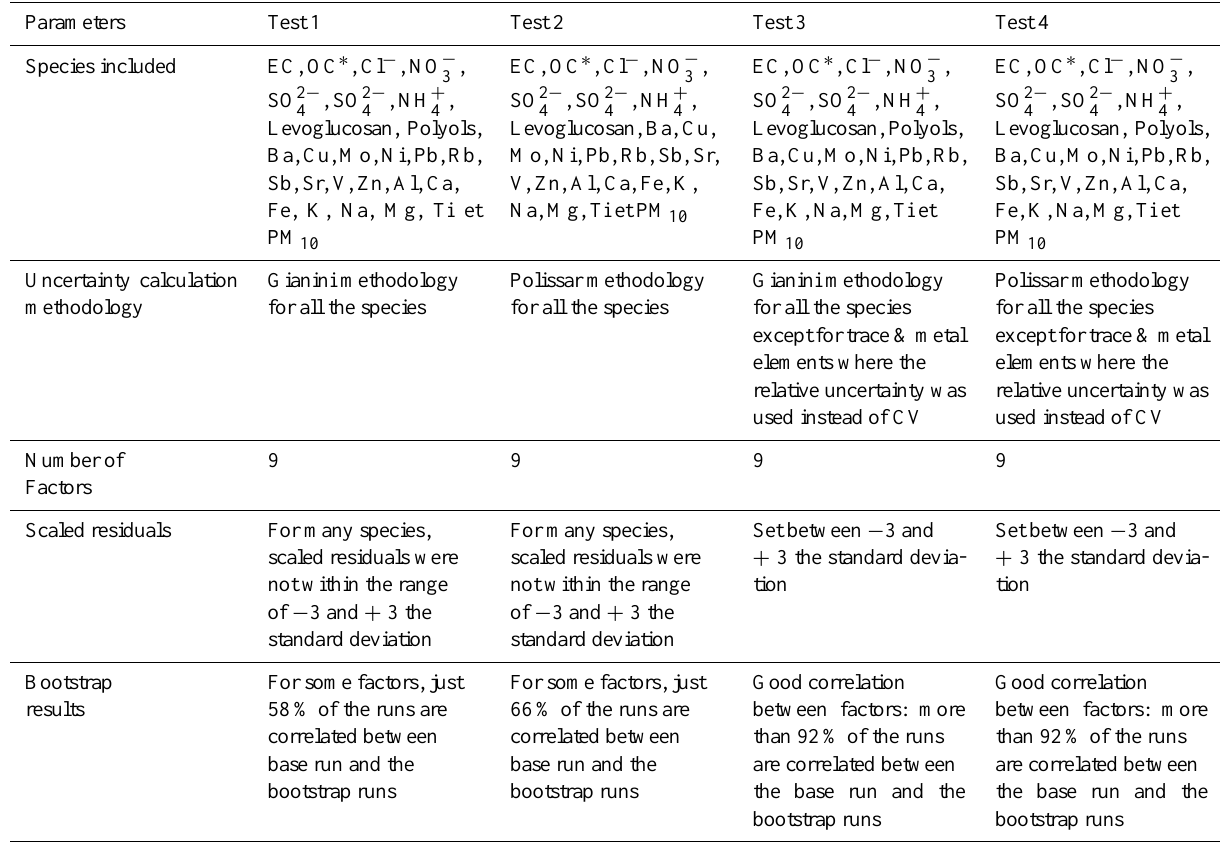
Table 2. Parameters used for the tests of uncertainty calculation methods and the associated stability results obtained in the base run. Parameters Test 1 Test 2 Test 3 Test 4 Species